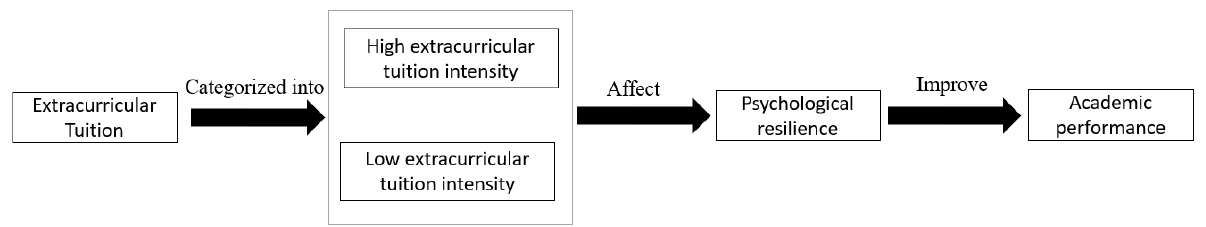
Figure 3. ET-AP effect mechanism.